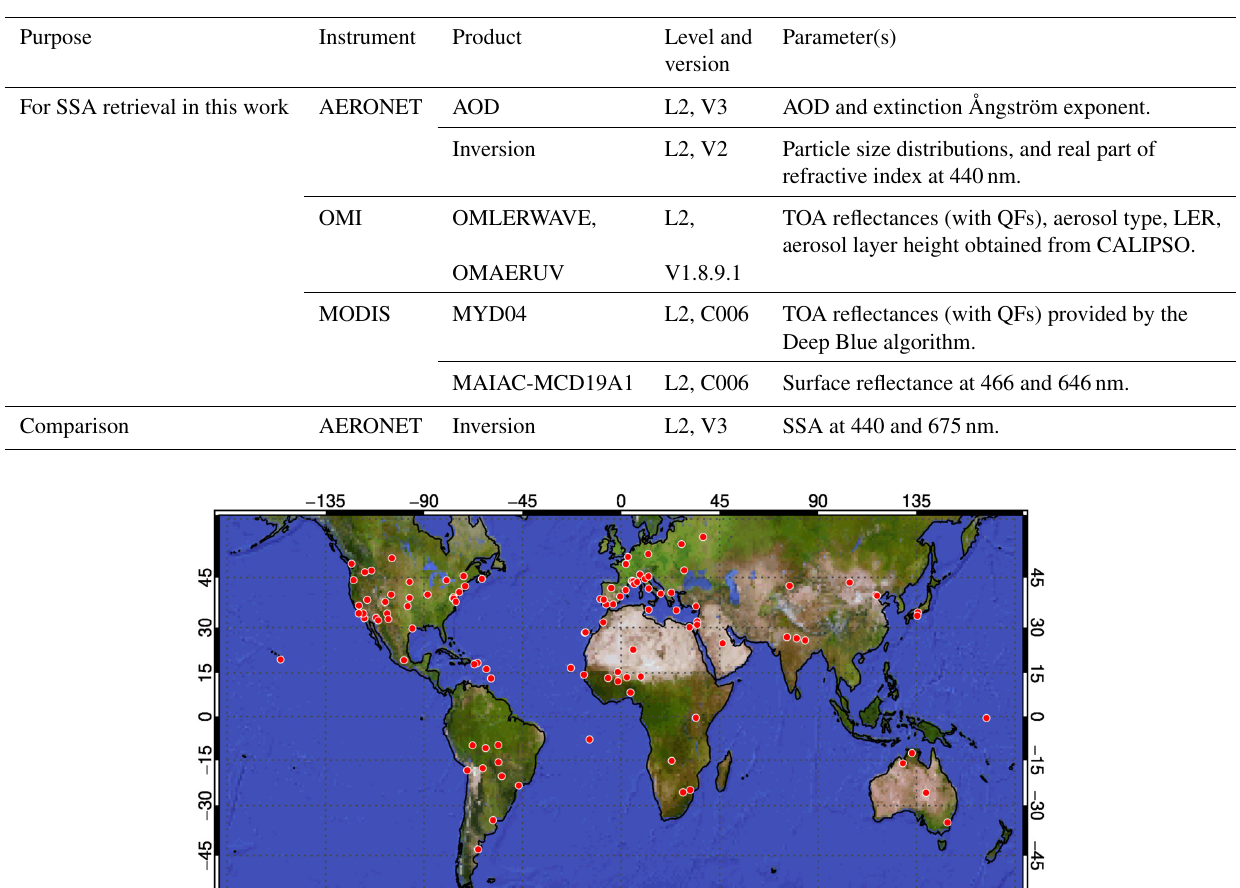
Table 1. Description of the ground and satellite data products used in this work.